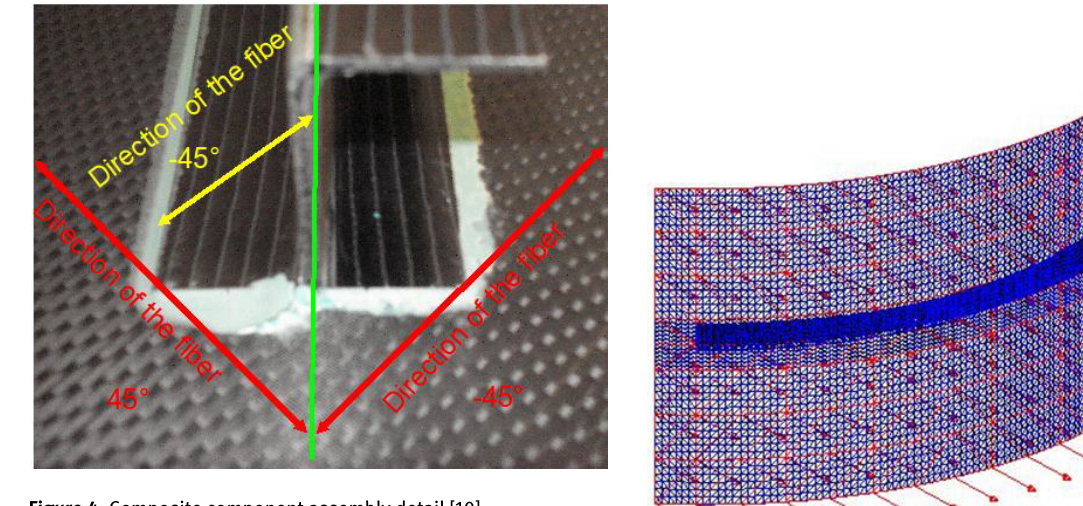
Figure 4: Composite component assembly detail [10].